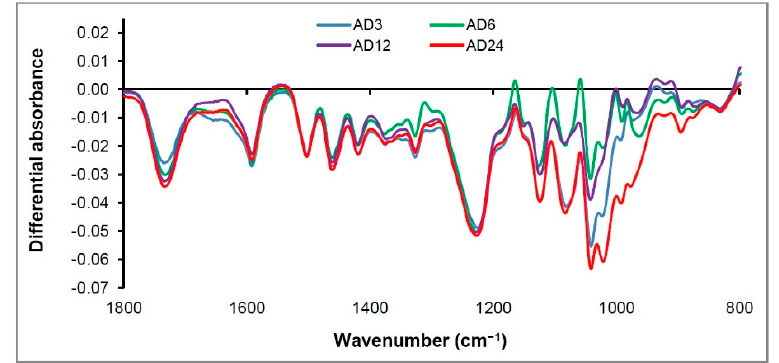
Figure 13. Differential Fourier Transform Infrared Spectroscopy ( FTIR) spectra of oak wood samples.